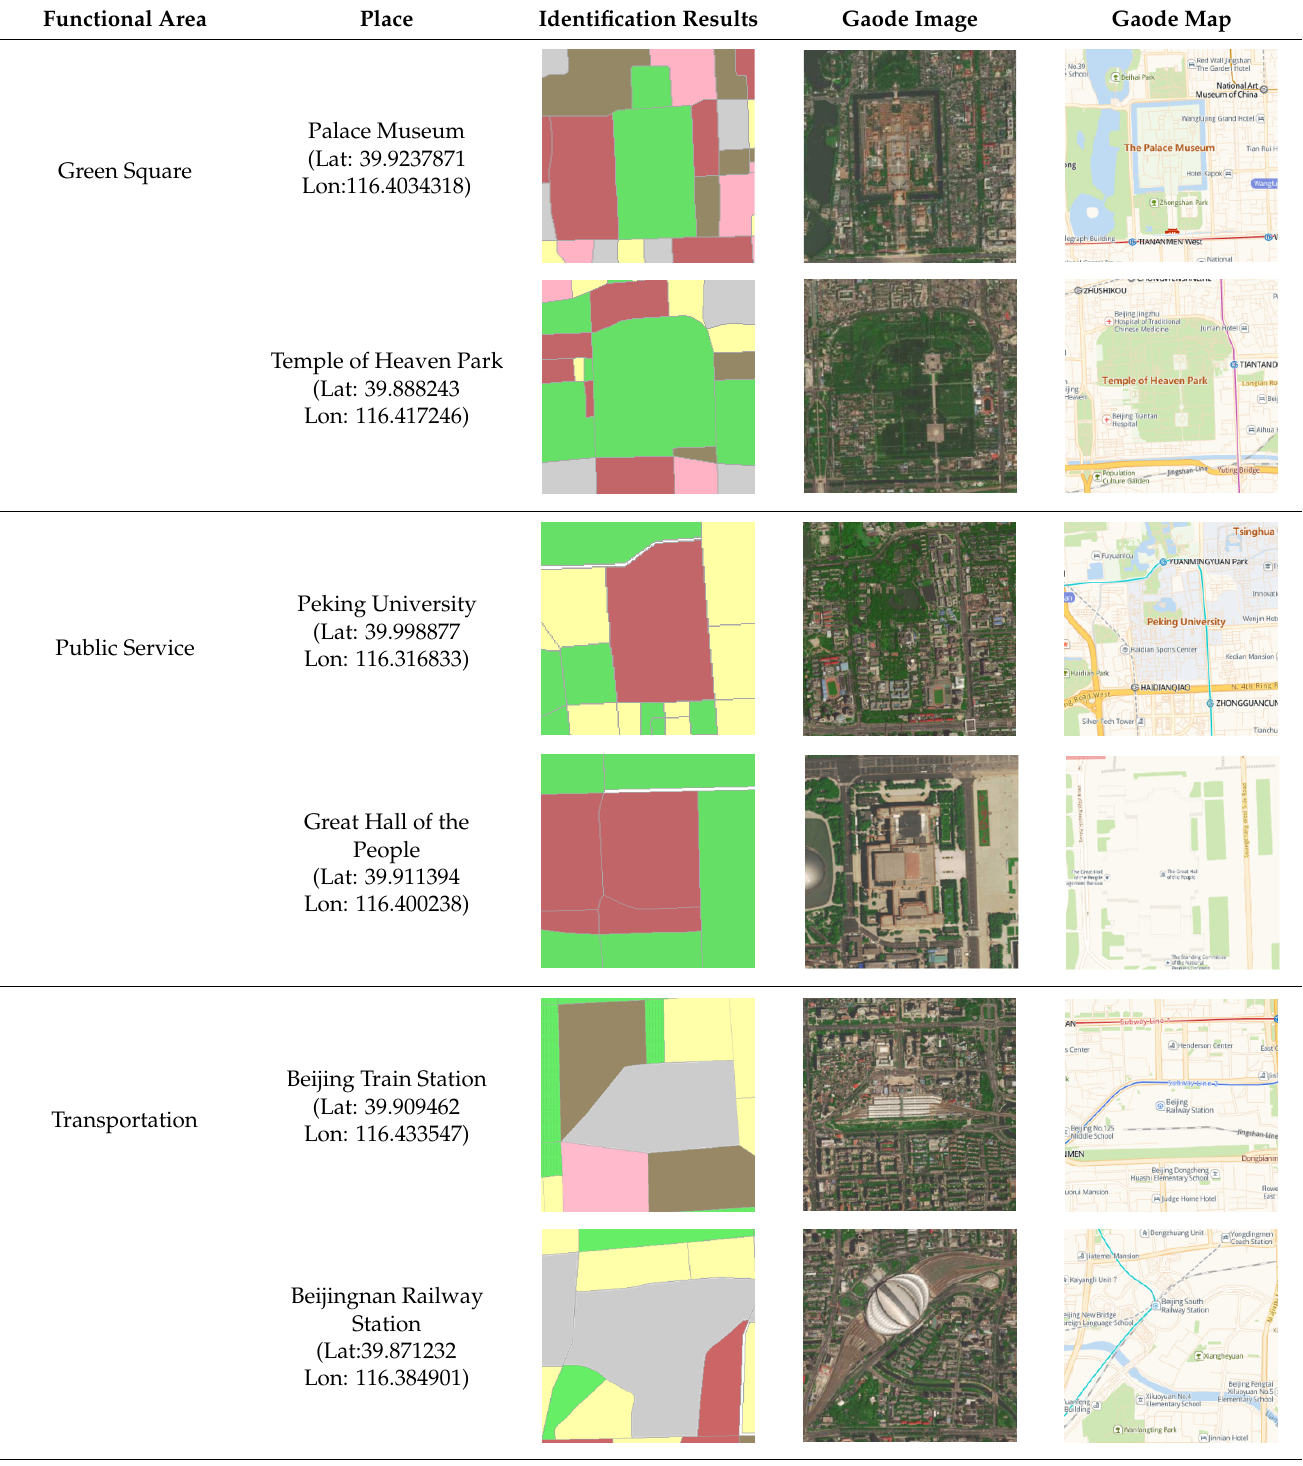
Table 5. Comparison of the functional area identification results.